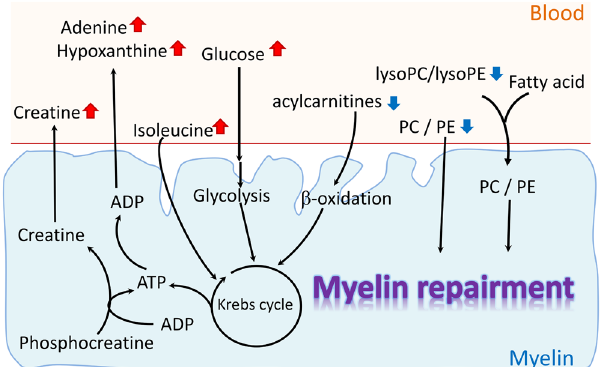
Figure 4. A simple diagram to illustrate the lipid metabolites disturbance in GBS patients. Decreased plasma levels of PCs, lysoPCs/lysoPEs reveal that myelin cells may recruit those lipids to myeline repairment. And the increased plasma levels of adenine, hypoxanthine, creatine, and glucose react to the energy demand for myelin